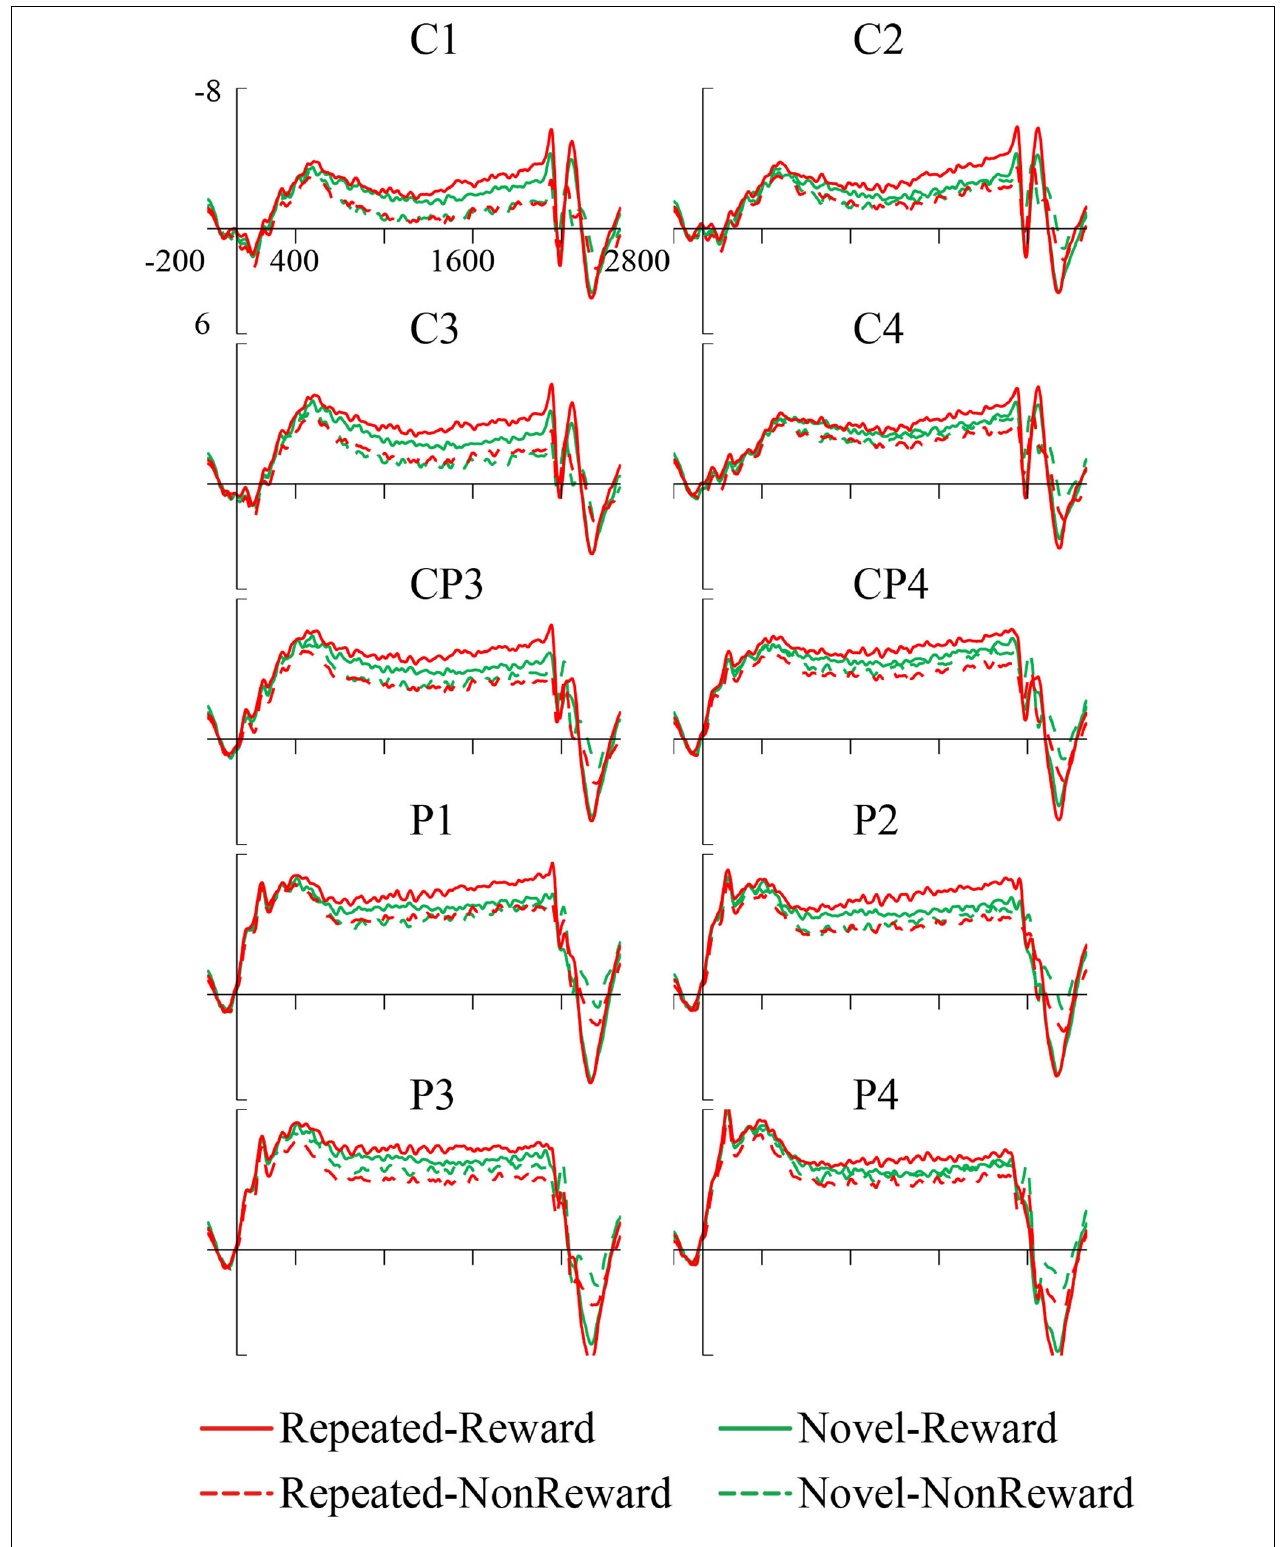
FIGURE 3 | Grand average stimulus-preceding negativity (SPN) event-related potentials (ERPs) to feedback stimuli for each configuration and reward condition at C1, C2, C3, C4, CP3, CP4, P1, P2, P3, and P4.